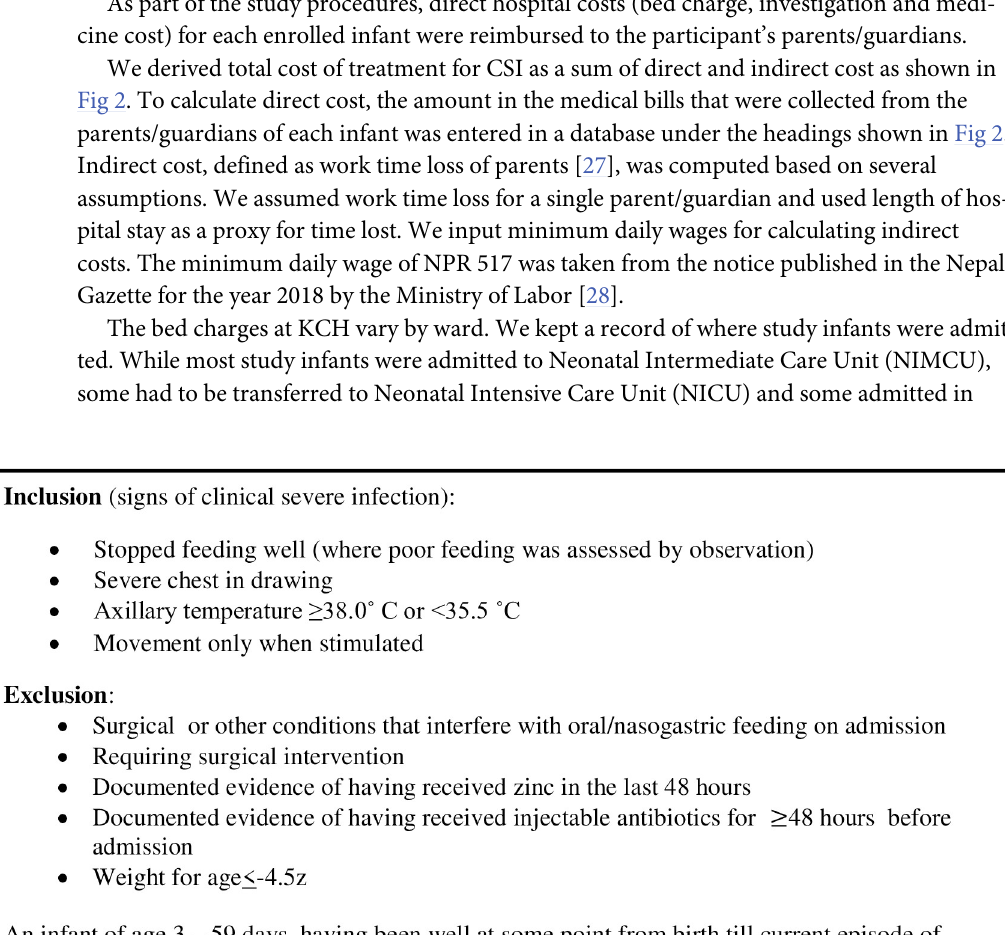
Fig 1. Eligibility criteria for study